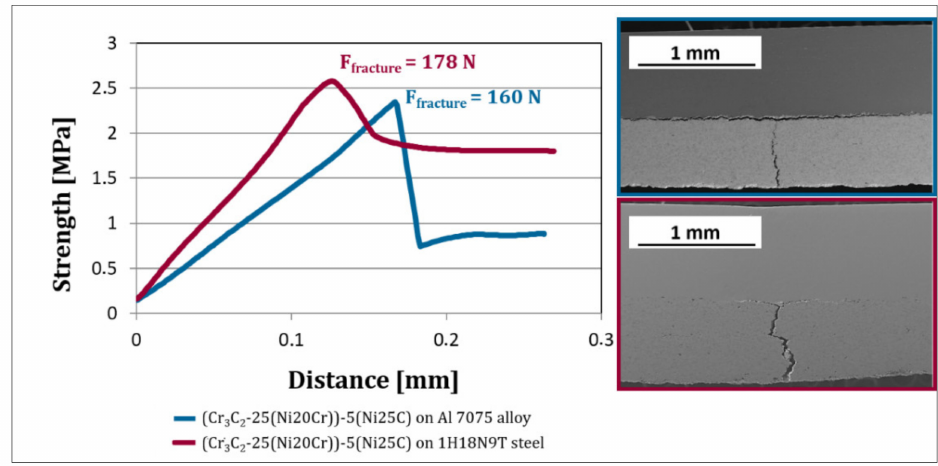
Figure 11. Strength versus displacement of the samples during the three-point bending test and SEM-BSE cross-section microstructures of the coating–substrate systems after the test. The substrate affects the three-point bending results of the coating–substrate